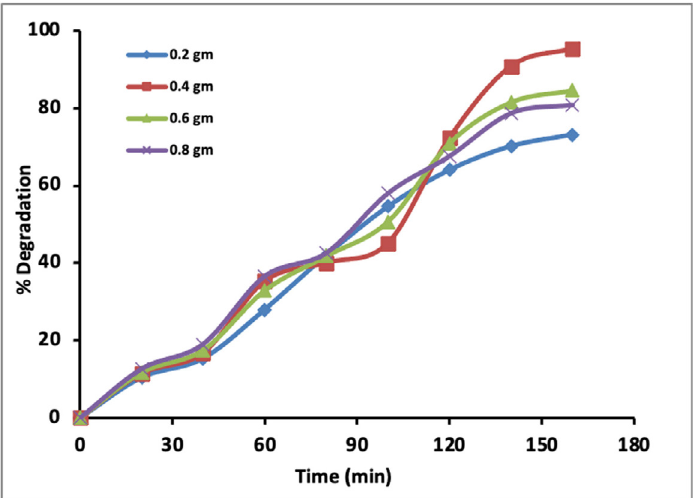
Fig. 10. Effect of amount of catalyst on industrial wastewater degradation.